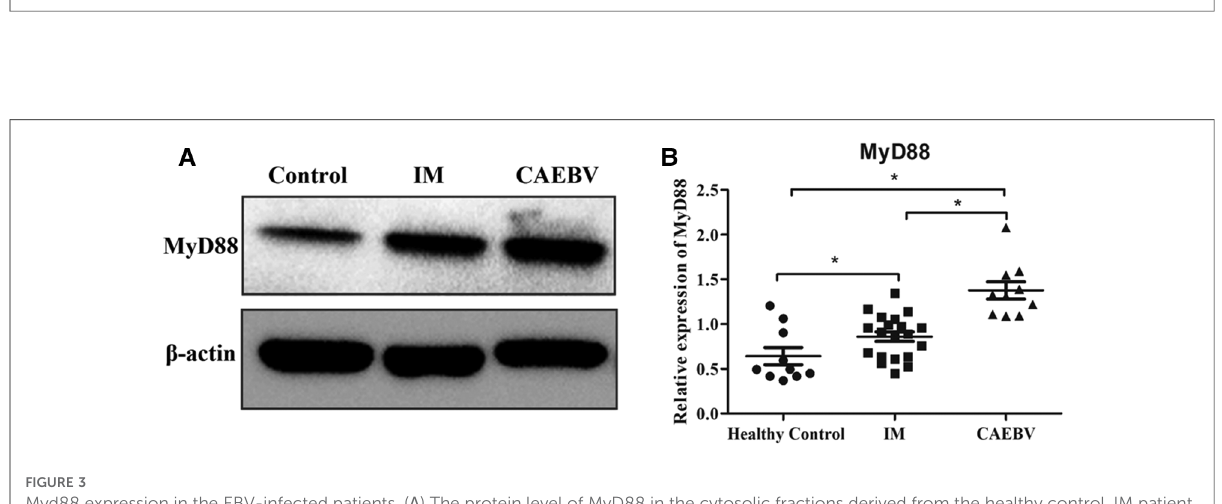
FIGURE 2 TLR9 expression is associated with EBV infection. ( A ) The level of TLR9 mRNA was measured in PBMCs from healthy controls (age matched, n =20), IM patients ( n =20) and CAEBV patients ( n =10). ( B ) Flow cytometry analysis showed the levels of TLR9 protein. ( C ) The expression of TLR9 in CD19+ B lymphocytes by fl ow cytometry analysis. ( D ) The expression of TLR9 in CD14+ monocytes by fl ow cytometry analysis. (* p <0.05 by Duncan ’ s test).